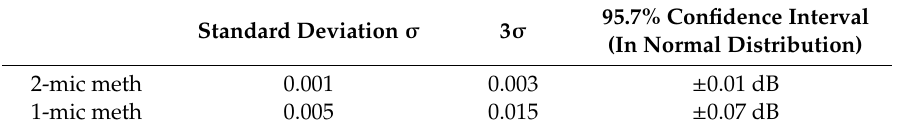
Table 1. Statistical parameters for the two-microphone and one-microphone measurement